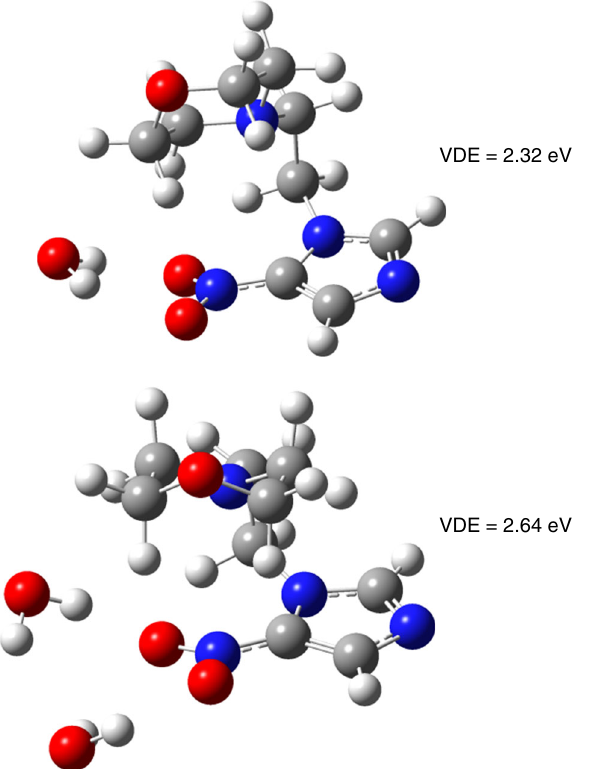
Fig. 5 Lowest energy conformers of hydrated anionic nimorazole. The calculations were performed for one (top) and two (bottom) water molecules. The anions were optimized at M062x/6 – 31 + G(d,p) level of theory and basis set. The corresponding vertical detachment energy (VDE) is shown respectively. Colour coding: Carbon (grey), hydrogen (white), nitrogen (blue), oxygen